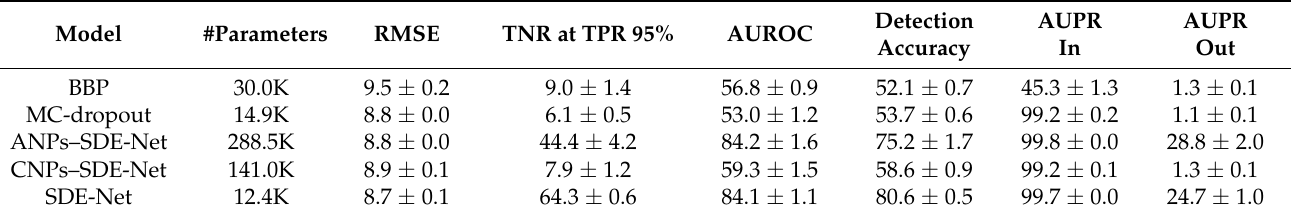
Table 2. OOD detection for regression on YearPredictionMSD + Boston